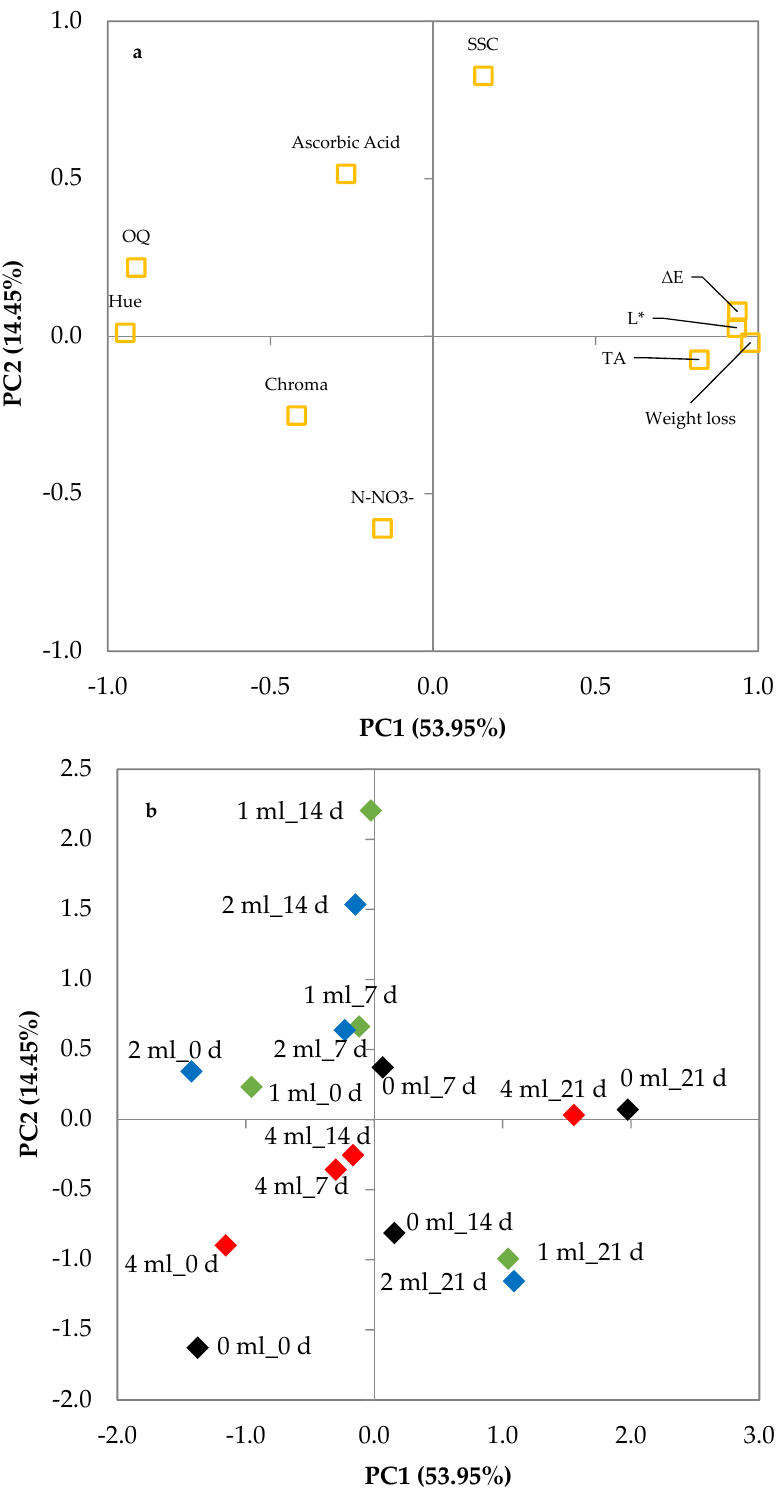
Figure 7. Plot of ( a ) loadings (quality characteristics of minimally processed leaf lettuce during 21 d of storage at 4 ◦ C) and ( b ) scores (trials) formed by the two principal components from the Principal Component Analysis. Leaf lettuce cultivated in nutrient solutions with 0 (black rhombuses), 1 (green rhombuses), 2 (blue rhombuses), and 4 mL L − 1 (red rhombuses) of Ecklonia maxima extract; _0d, _7d, _14d, and_21d: days of storage at 4 ◦